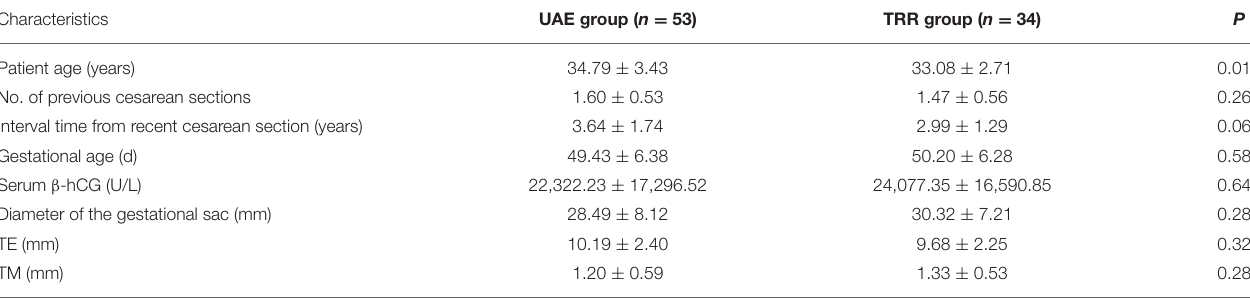
TABLE 1 | Baseline clinical characteristics of participants before surgery. Characteristics